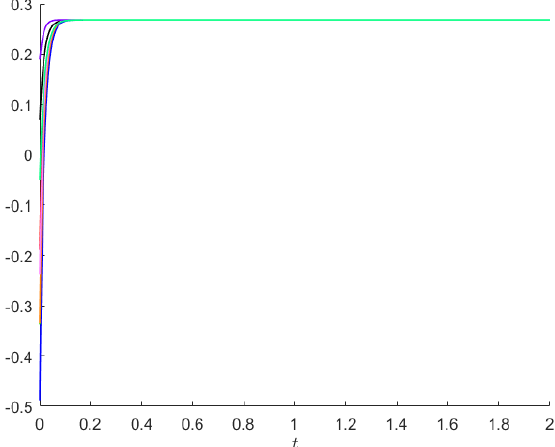
Figure 5. For Example 3, from 8 initial values (each shown using a separate color), are depicted the trajectories of state χ 1 .